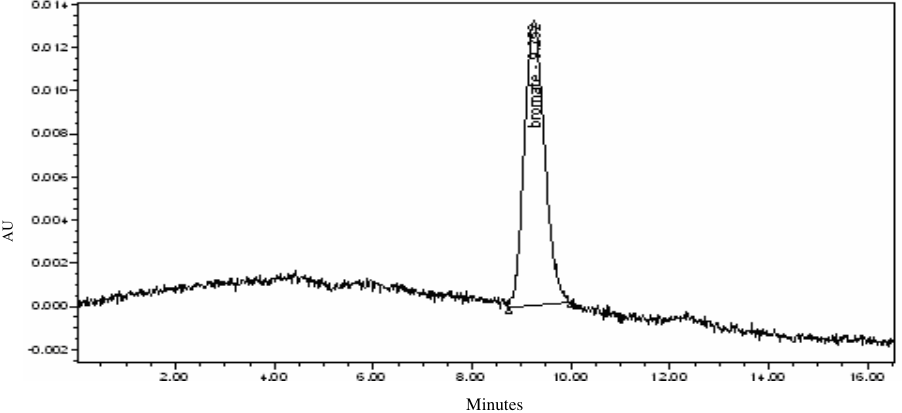
Figure 4. Analysis of mixture of 100 µg/L bromate standard and 100 µg/L nitrite solution with HPLC system, chromatographic conditions are listed under experimental conditions, wavelength 450 nm